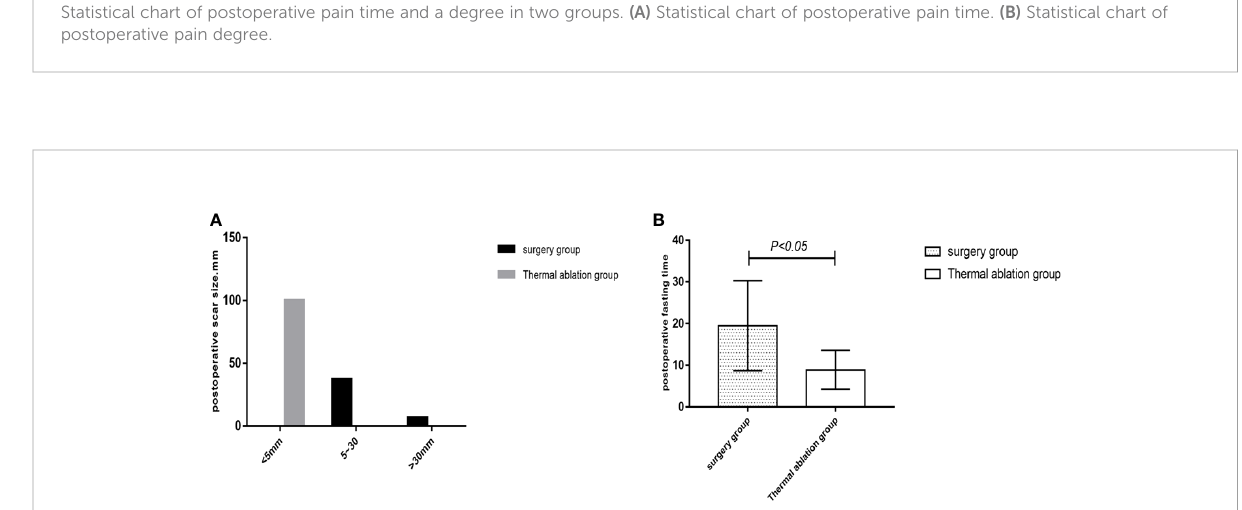
FIGURE 5 Statistical chart of postoperative scars and fasting time in the two groups. (A) Statistical chart of postoperative scars. (B) Statistical chart of postoperative fasting time.